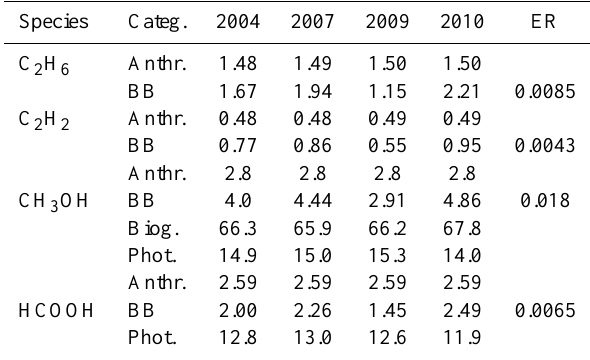
Table 4. Sources of C 2 H 6 , C 2 H 2 , CH 3 OH and HCOOH in the Southern Hemisphere in Tgyr − 1 , as implemented in the stan- dard simulation of the IMAGES model, for the different categories (Categ.): anthropogenic (Anthr.), biomass burning (BB), biogenic (Biog.), and photochemical (Phot.). The Southern Hemispheric emission ratios (ER), from IMAGESv2, of the species relative to CO are also given in mole/mole.